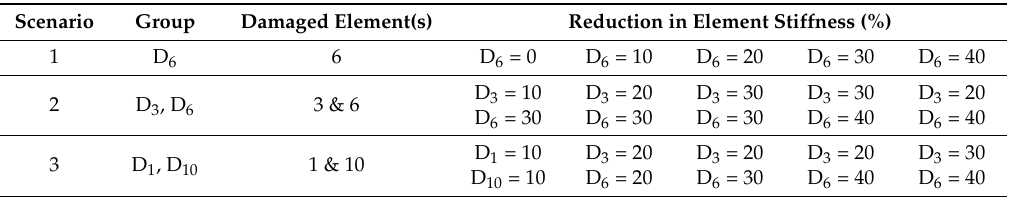
Table 1. Description of damage scenarios in the numerical simulations.